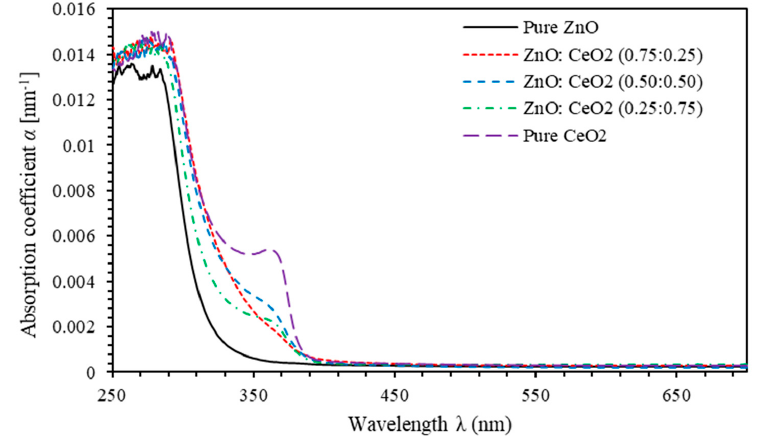
Figure 7. Absorption coe ffi cient spectra of pure ZnO, pure CeO 2 and ZnO:CeO 2 mixed oxides thin films.